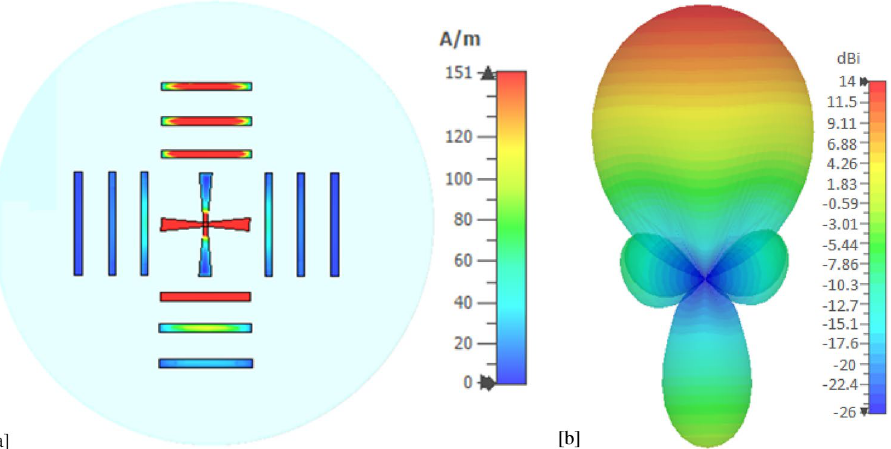
Figure 4. ( a ) Current distribution and ( b ) 3D far-field radiation pattern of the antenna at 1.25 THz in mode 1.